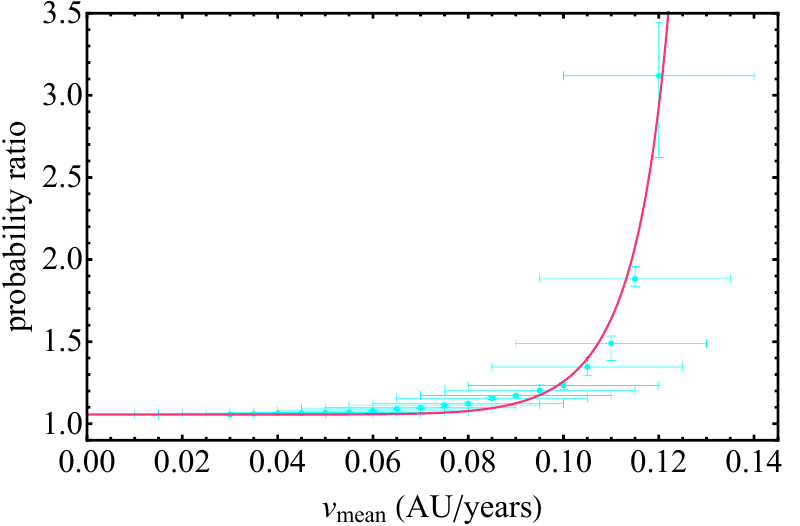
Figure 3. The cyan points correspond to the ratio of the probability for comets to enter our Solar system after the 10% gravitational transition, over the same probability before the transition, for different values of random initial velocity perturbations ( v mean ) on the initial comet velocity. The red line corresponds to a non linear fit of the numerical results in the form of an exponential